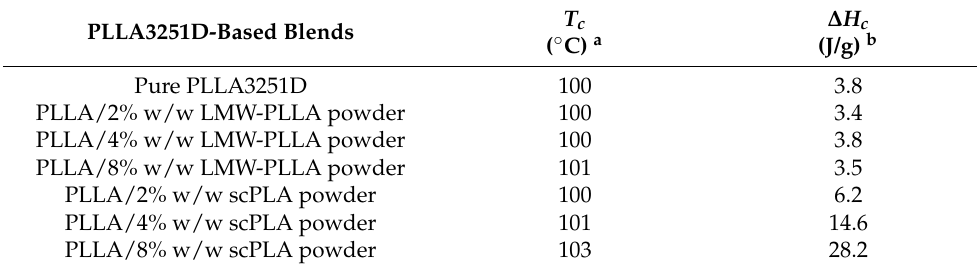
Figure 6. DSC cooling curves of ( a ) pure PLLA3251D and PLLA3251D/LMW-PLLA powder blends with powder contents of ( b ) 2%, ( c ) 4%, and ( d ) 8% w / w as well as PLLA3251D/scPLA powder blends with powder contents of ( e ) 2%, ( f ) 4%, and ( g ) 8% w / w ( T c peaks as shown). Table 4. Crystallization properties of PLLA3251D/LMW-PLLA powder and PLLA3251D/scPLA powder blends from DSC cooling curves in Figure 6.